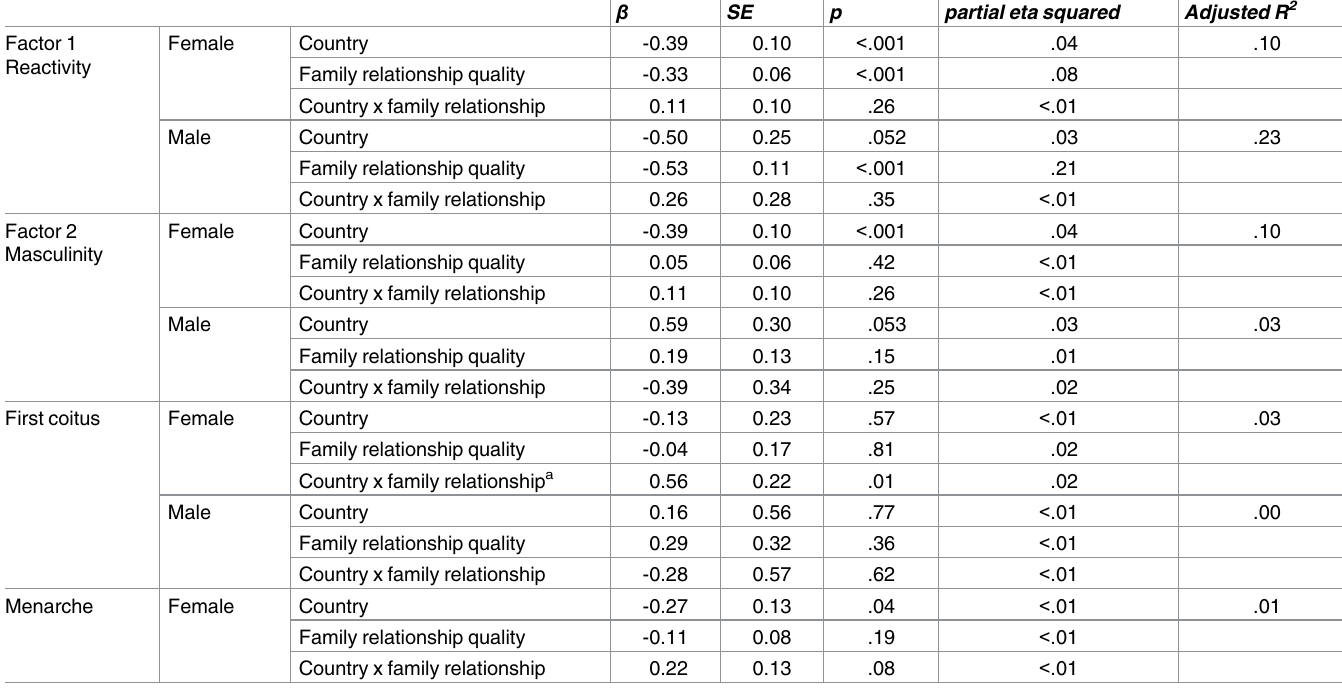
Table 5. Regression analysesshowing associations between family relationship scores and outcome measuresfor female and male participants. (Reference category for Country is